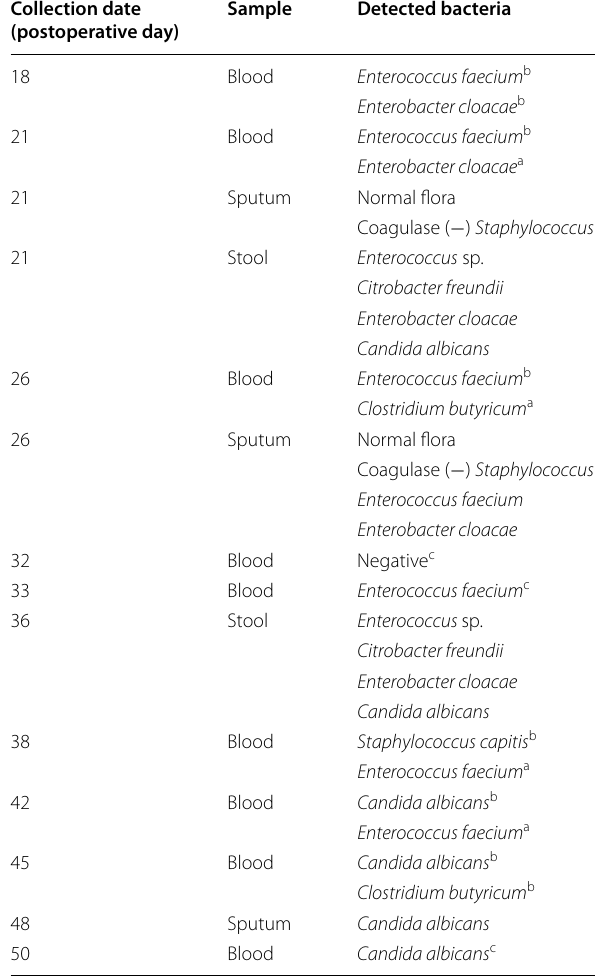
Table 1 Postoperative culture test of case